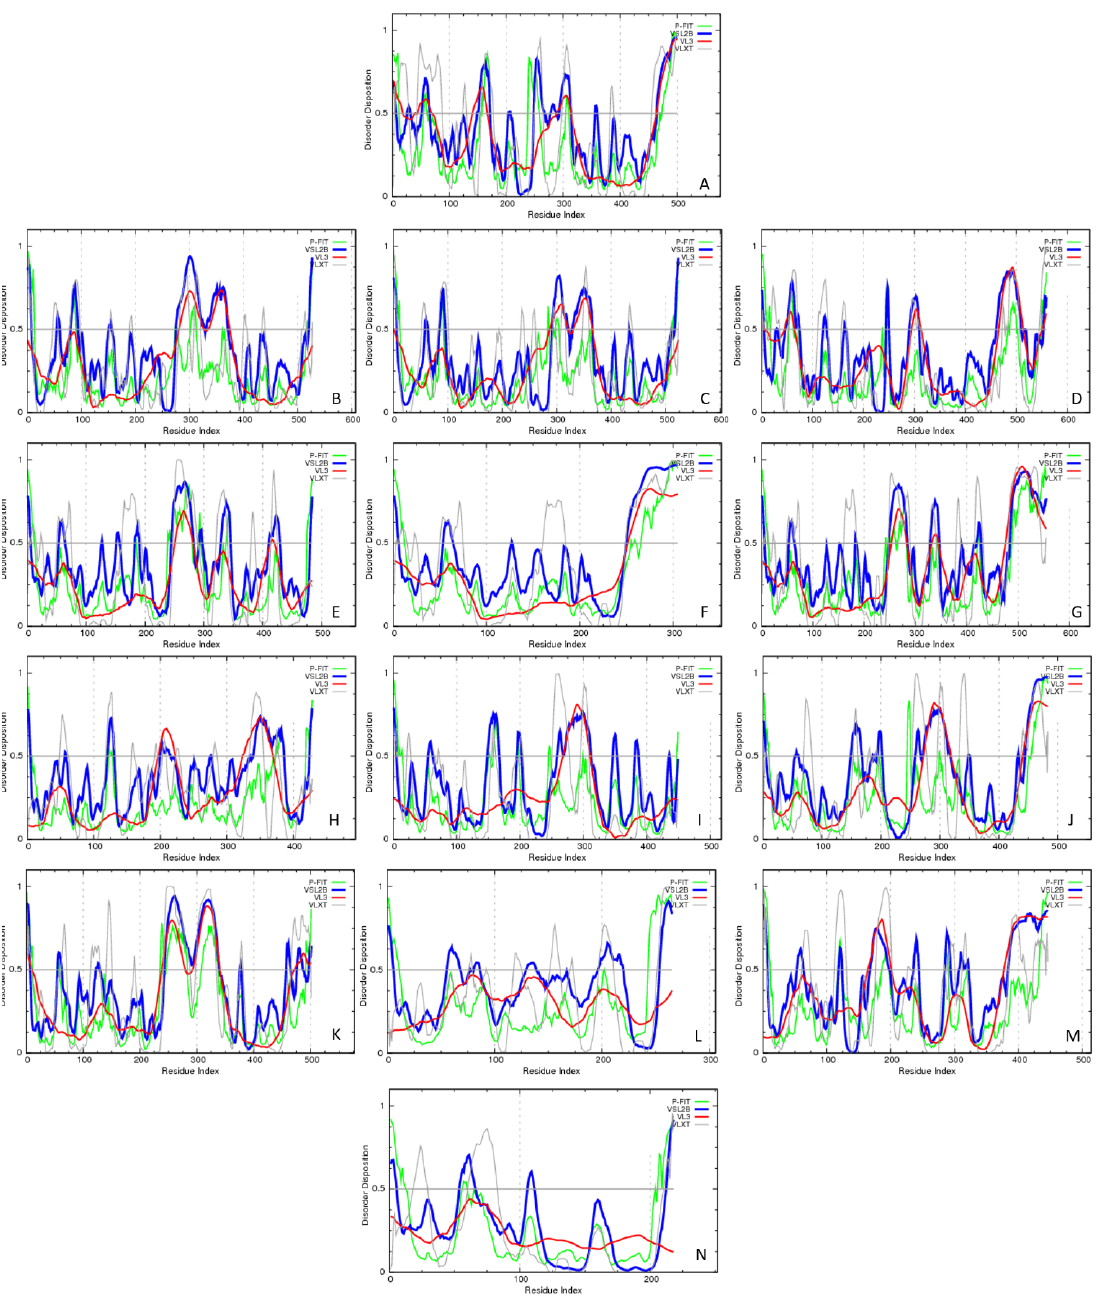
Figure 2. Per-residue disorder propensities of human butyrophilins as evaluated by the members of PONDR family. ( A ) BTN1A1. ( B ) BTN2A1. ( C ) BTN2A2. ( D ) BTN2A3. ( E ) BTN3A1. ( F ) BTN3A2. ( G ) BTN3A3. ( H ) BTNL2. ( I ) BTNL3. ( J ) BTNL8. ( K ) BTNL9. ( L ) BTNL10. ( M ) ERMAP. ( N ) MOG. Outputs for PONDR ® VLXT, PONDR ® VL3, PONDR ® VSL2, and PONDR ® FIT are shown by gray, red, blue, and green lines, respectively. A disorder threshold is indicated as a thin line (at score = 0.5) in all plots to show a boundary between disorder (>0.5) and order (<0.5).